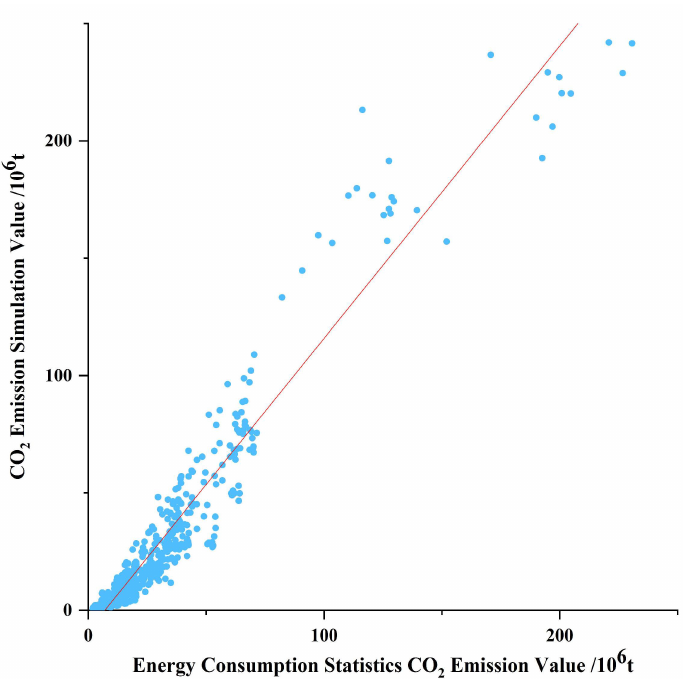
Figure 4. Scatter plot of energy statistics CO 2 emission values and fitted CO 2 emission